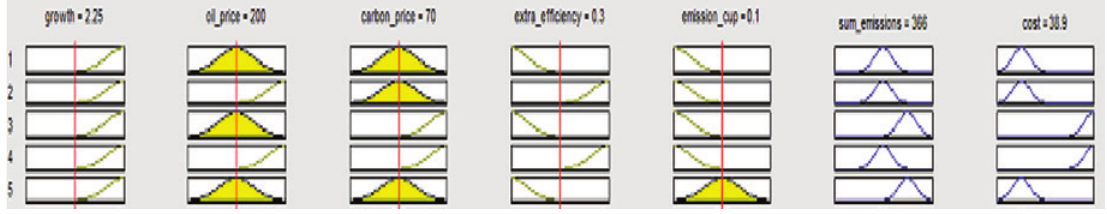
Figure 3: Examples of Fuzzy Rules through the Fuzzy Toolbox, Matlab Software.